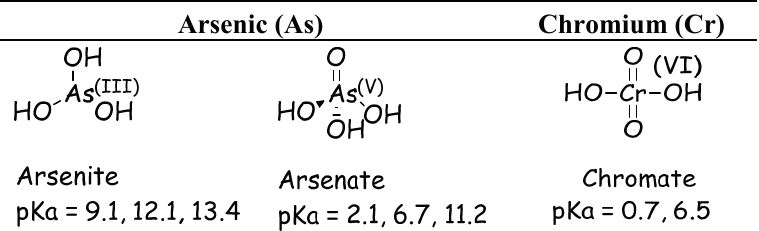
Table 1. pKa and speciation of chromium and arsenic. Arsenic